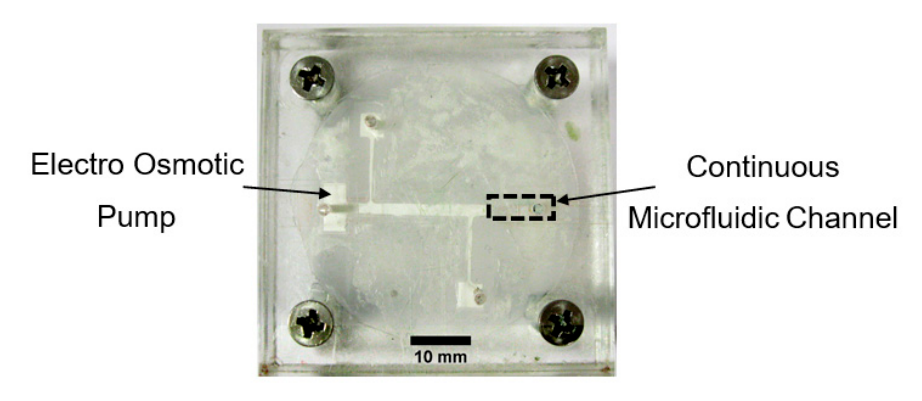
Figure 4. Photograph of the fabricated device.